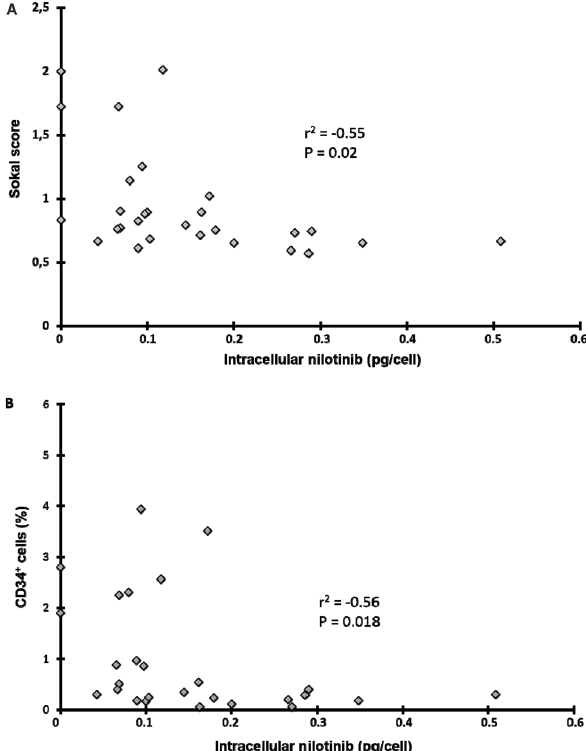
Figure 4. Relationship between intracellular nilotinib concentration in PMN cells and tumour burden in patients who received first-line treatment with nilotinib. Relationship between nilotinib concentration in mature PMN cells and ( A ) Sokal prognostic score at diagnosis and ( B ) percentage of CD34 + cells in peripheral blood (n = 25